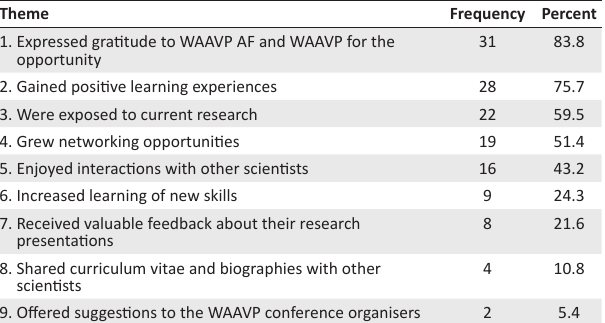
TABLE 2: Nine emerging categories/themes were identified from 37 narratives in which recipients expressed their views pertaining to the World Association for the Advancement of Veterinary Parasitology African Foundation scholarships and attendance at the respective conferences 2007–2017 ( n = 37).